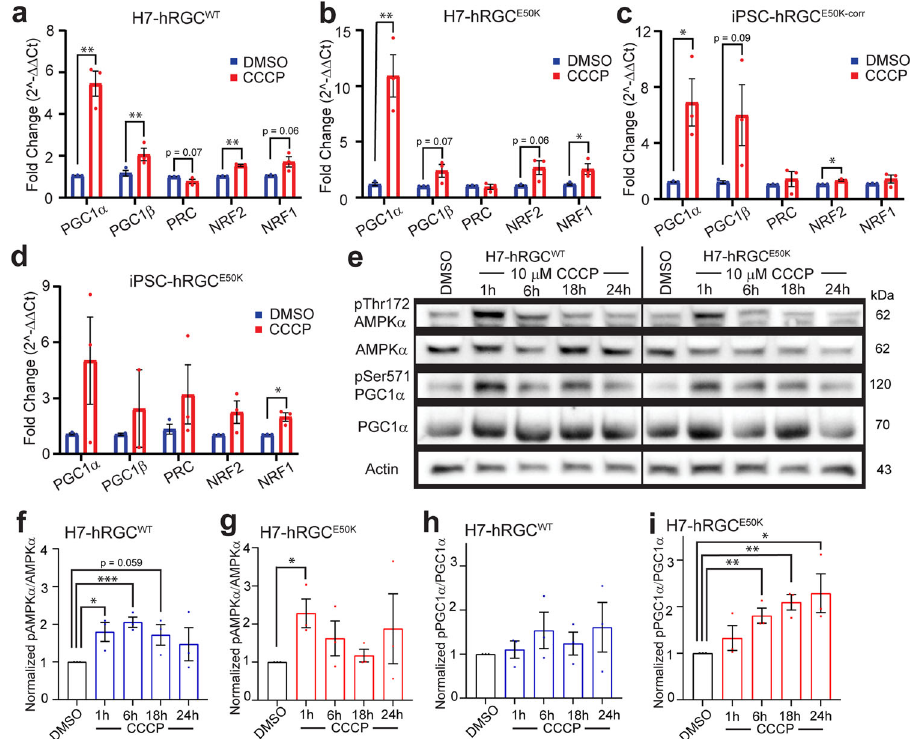
Fig. 3 Mitochondrial damage activates the AMPK α -PGC1 α biogenesis axis in hRGCs. Mitochondrial biogenesis gene expressions in a H7-hRGC WT , b H7-hRGC E50K , c iPSC-hRGC E50K-corr , and d iPSC-hRGC E50K after 24 h CCCP (10 μ M) treatment. ΔΔ Ct fold changes were measured relative to GAPDH, and then DMSO. n = 3, 3 technical repeats averaged for each biological repeat. e Representative western blot images of H7-hRGCs treated with 10 μ M CCCP for the indicated timepoints. f – i For each protein, band intensities were quanti fi ed and fi rst normalized to corresponding actin loading control, then to its DMSO values, f , g ratio between p-AMPK α Thr172 to AMPK α , and h , i ratio between p-PGC1 α Ser571 to PGC1 α . n = 3. Unpaired student ’ s t- test between DMSO and the individual CCCP timepoints. ٭ p -value < 0.05, ٭٭ p -value < 0.01, ٭٭٭ p -value < 0.001. Error bars are